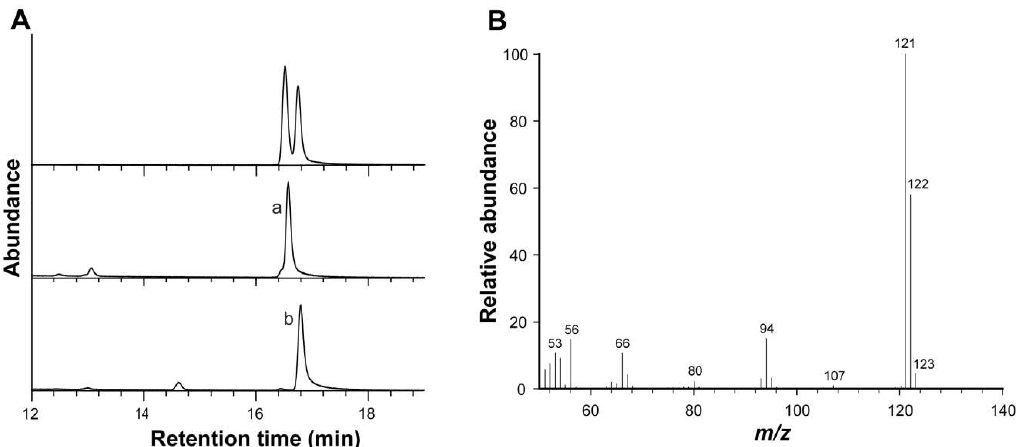
Figure 4. Gas chromatography–mass spectrometry (GC-MS) analysis of EMP using a DB-WAX column. ( A ) GC traces of HPLC-purified EMPa (middle panel) and EMPb (bottom panel) in comparison with the mixture (top panel); ( B ) mass spectra.